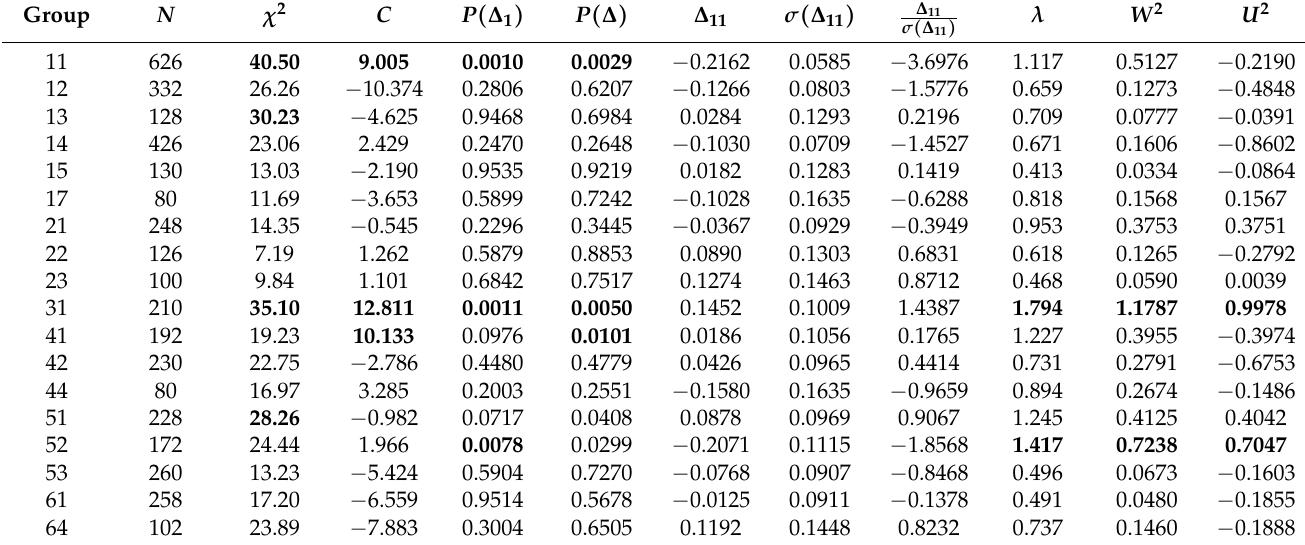
Table 5. Test for isotropy of the orientations of the galaxy plane. The distribution of the angle δ D of